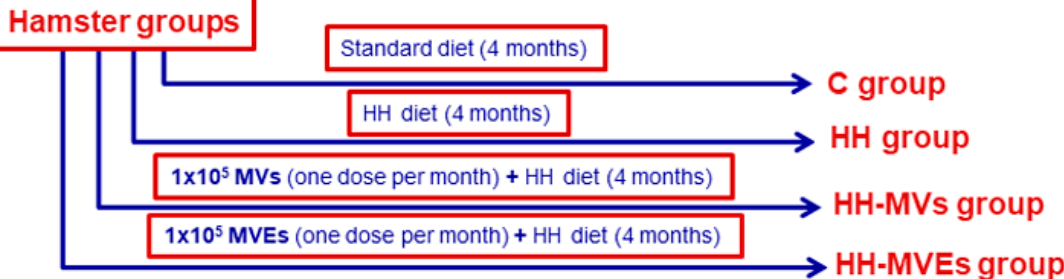
Figure 1. Graphic representation of animal experimental models. Golden Syrian hamsters were divided into four experimental groups: ( 1 ) control (C) group; ( 2 ) simultaneously hypertensive–hyperlipidemic (HH) group; ( 3,4 ) HH hamsters with retro-orbital sinus injection containing 1 × 10 5 microvesicles (MVs) (HH-MVs group) or 1 × 10 5 endothelial progenitor cell (EPC)-derived MVs (MVEs)